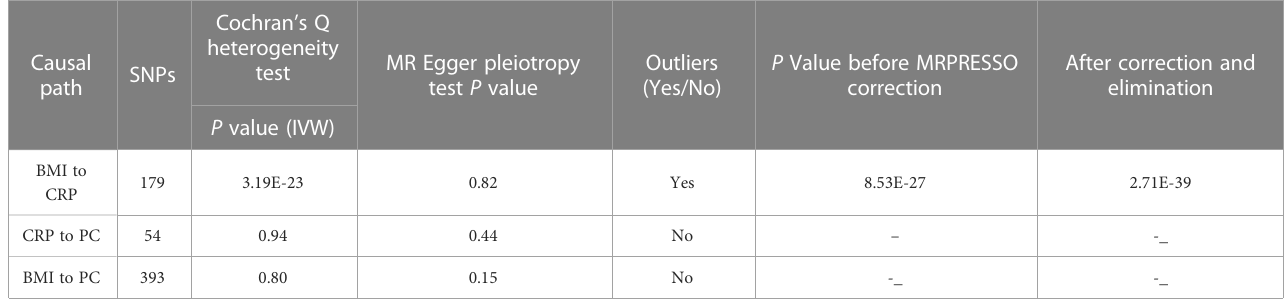
TABLE 2 The results of the heterogeneity and horizontal pleiotropy.